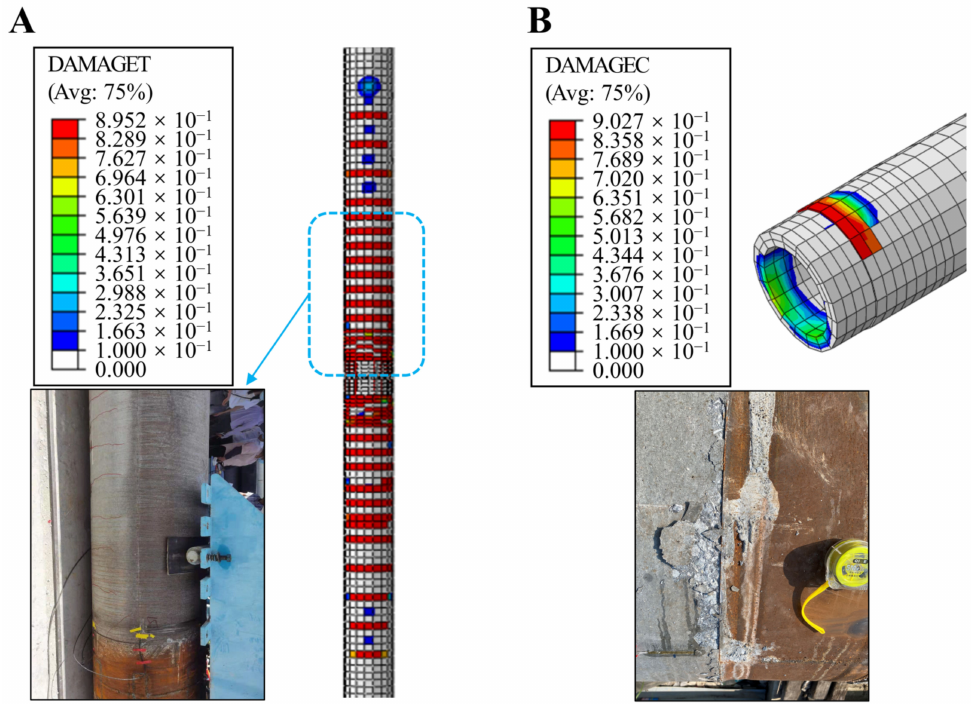
Figure 10. Damage of pipe pile concrete ( f = 250 mm): ( A ) tension; ( B )